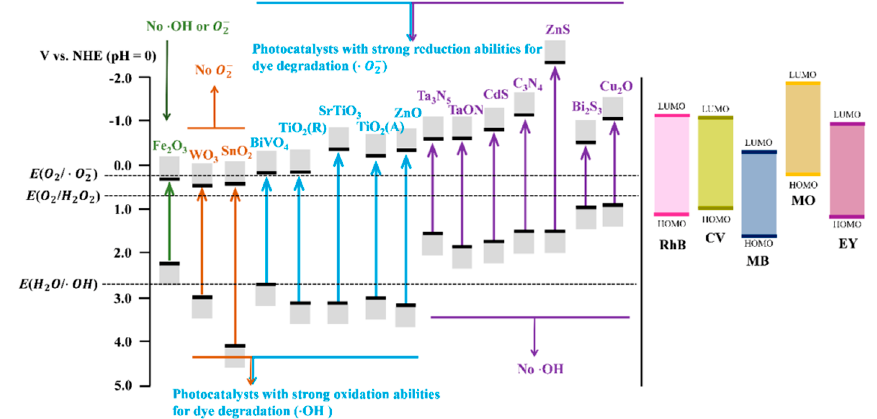
Figure 15. Scheme for the band structures of common photocatalysts, and potentials of the radical generation and HOMO and LUMO levels of five representative dye molecules.